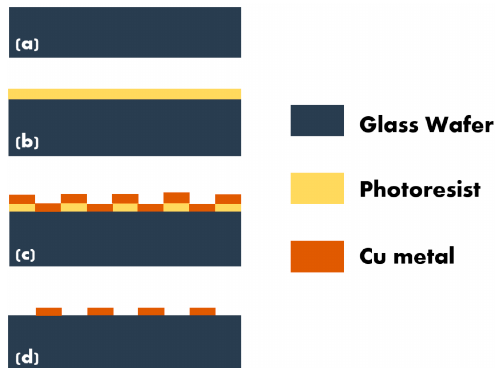
Figure 1. Schematic representation of process flow for the fabrication of Microelectrode Array: ( a ) Glass substrate; ( b ) Sacrificial layer; ( c ) Patterning the sacrificial layer and ( d ) deposition of the target material.